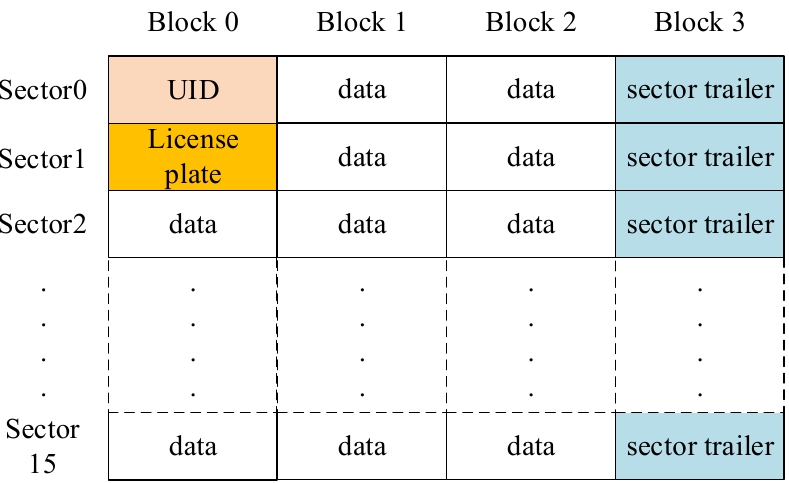
Figure 11. RFID memory configuration diagram.